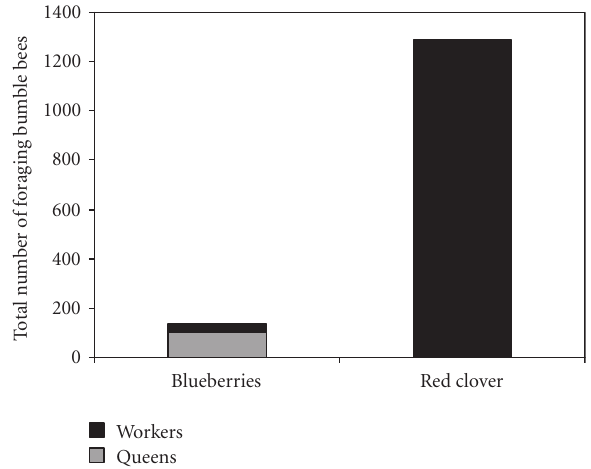
Figure 3: Comparison of the numbers of queens and workers of B. vosnesenskii observed foraging on bloom ( n = 127 counts) and red clover ( n = 187